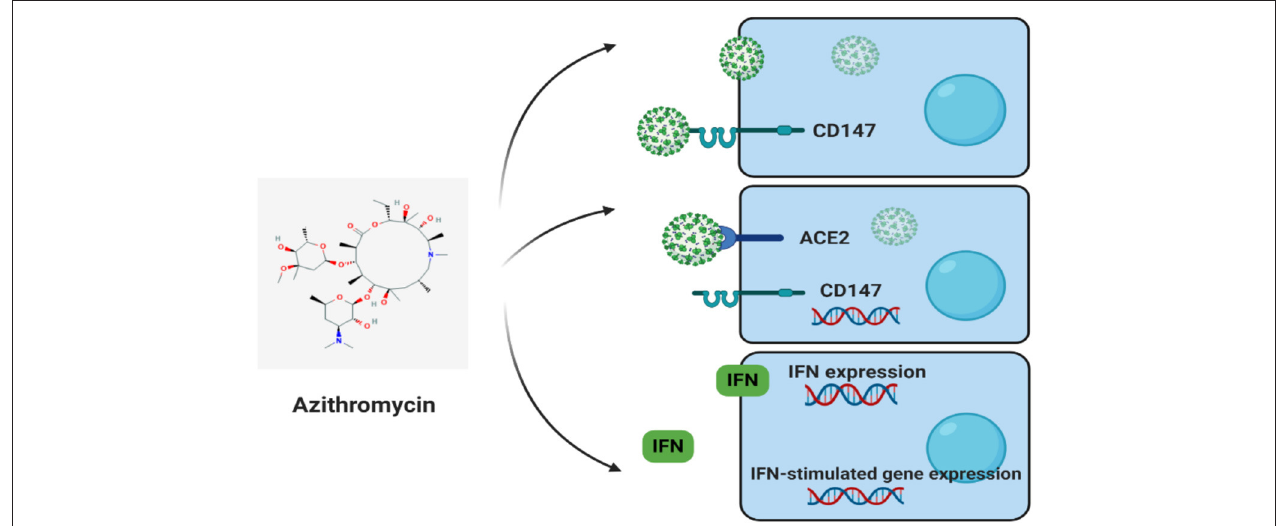
FIGURE 2 | Targets and conceivable treatments for coronavirus